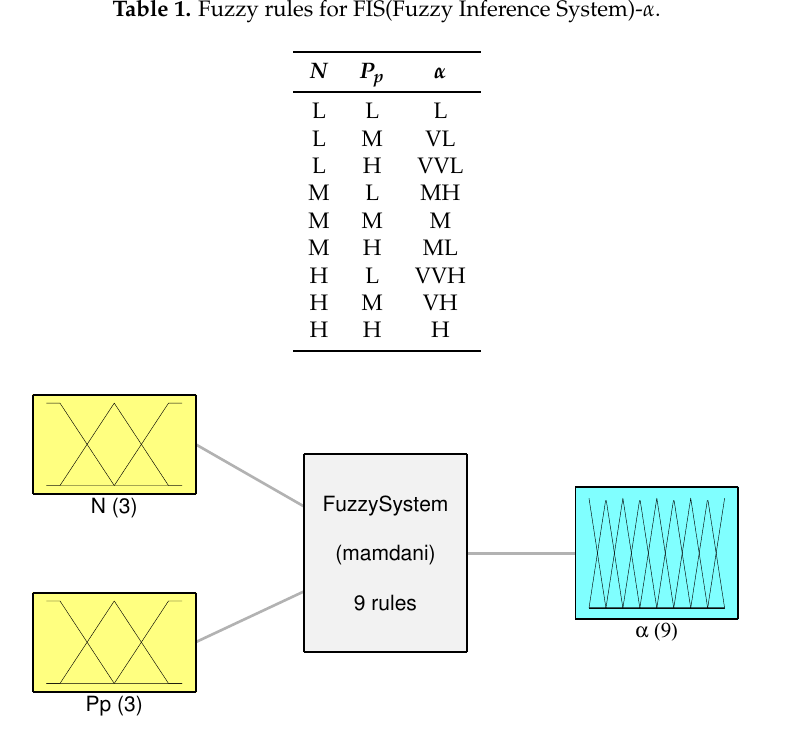
Figure 4. Architecture of Fuzzy Inference System (FIS) to adjust α